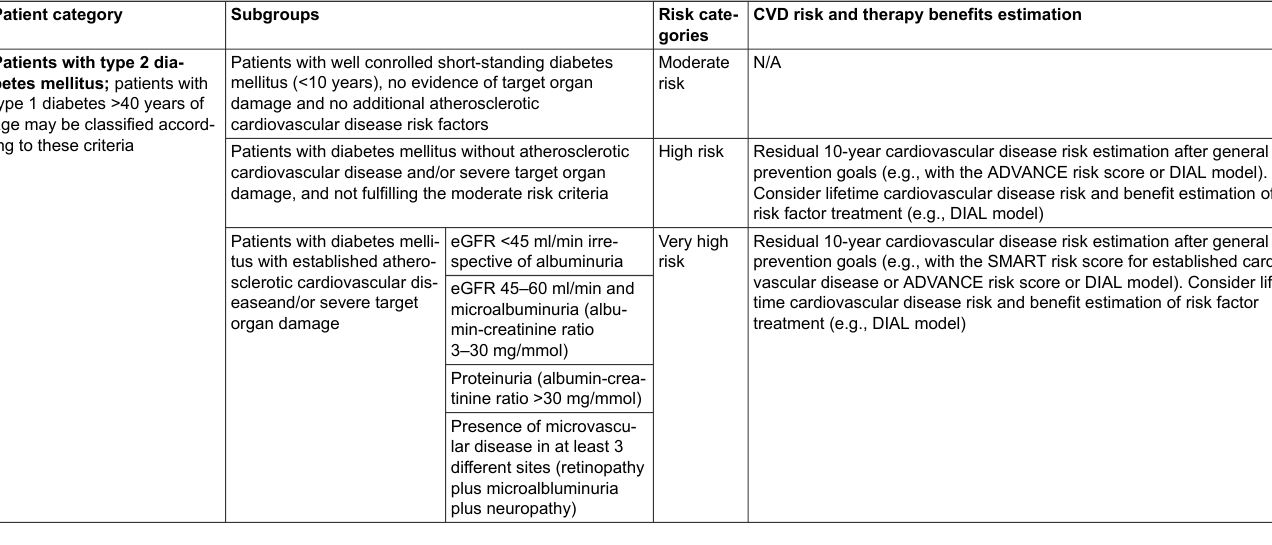
Table 1: Cardiovascular risks in diabetes (ESC 2021) [17]. Patient category Subgroups Risk cate- Patients with type 2 dia- betes mellitus; patients with type 1 diabetes >40 years of age may be classified accord- ing to these